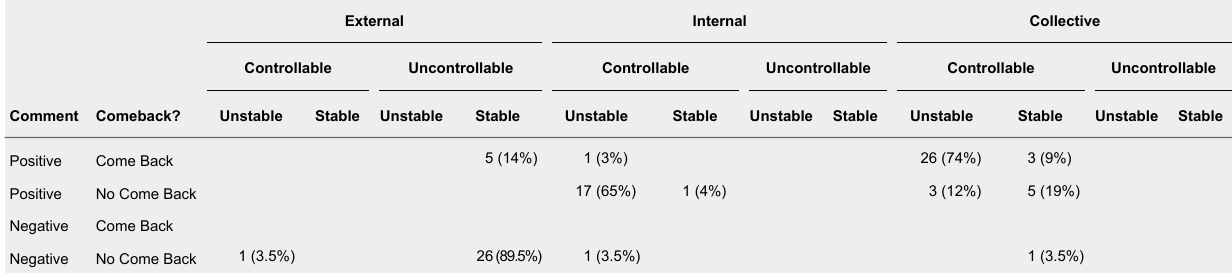
Overall Attributional Comments Made by Ousted Party